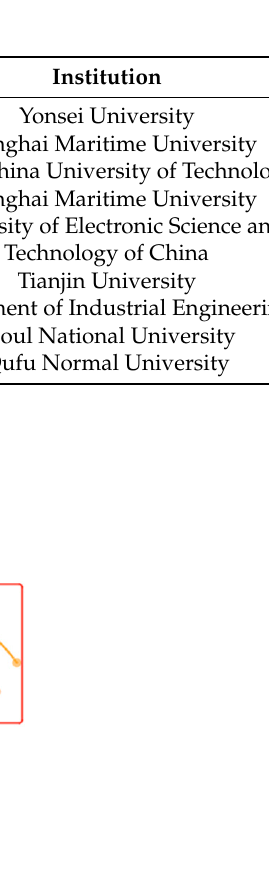
Table 2. Top 8 active authors.